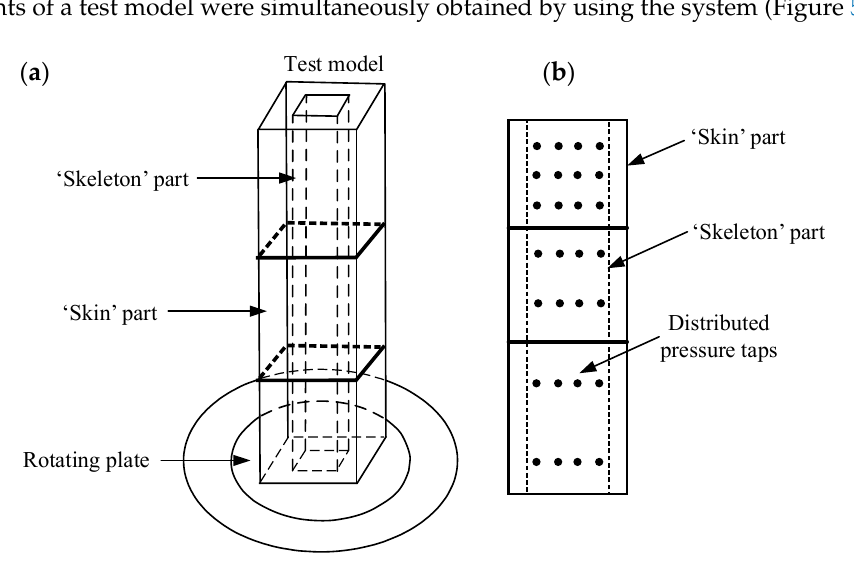
Figure 5. A base force–pressure–aeroelastic integrated model, after [37]: ( a ) Global view of the hybrid aeroelastic-force-pressure measurement system; ( b ) Side view of the bluff body in hybrid aeroelastic-force-pressure measurement system.